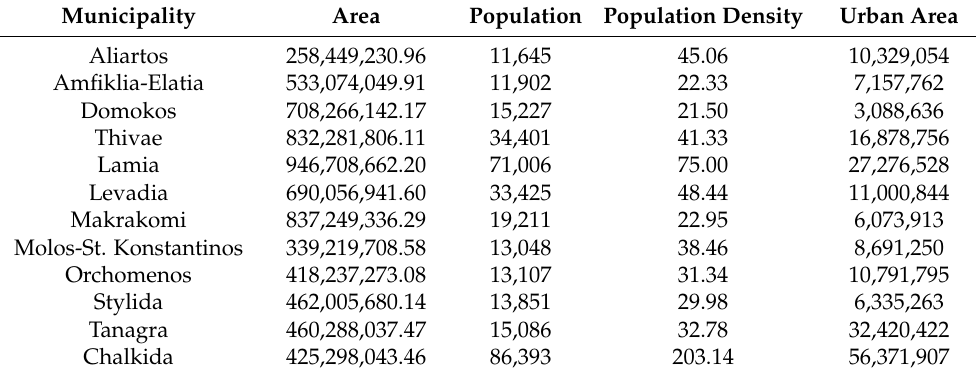
Table A1. Population and density data on the 12 municipalities involved in the current study.